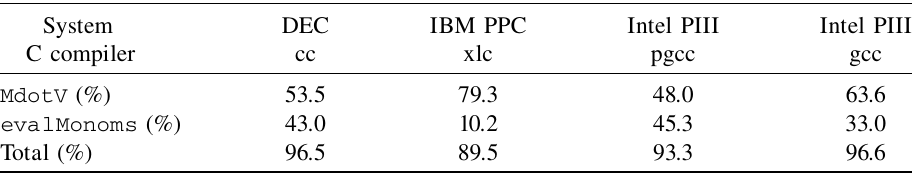
TABLE I. Percentage of time spent in the two principal CTRACK subroutines.